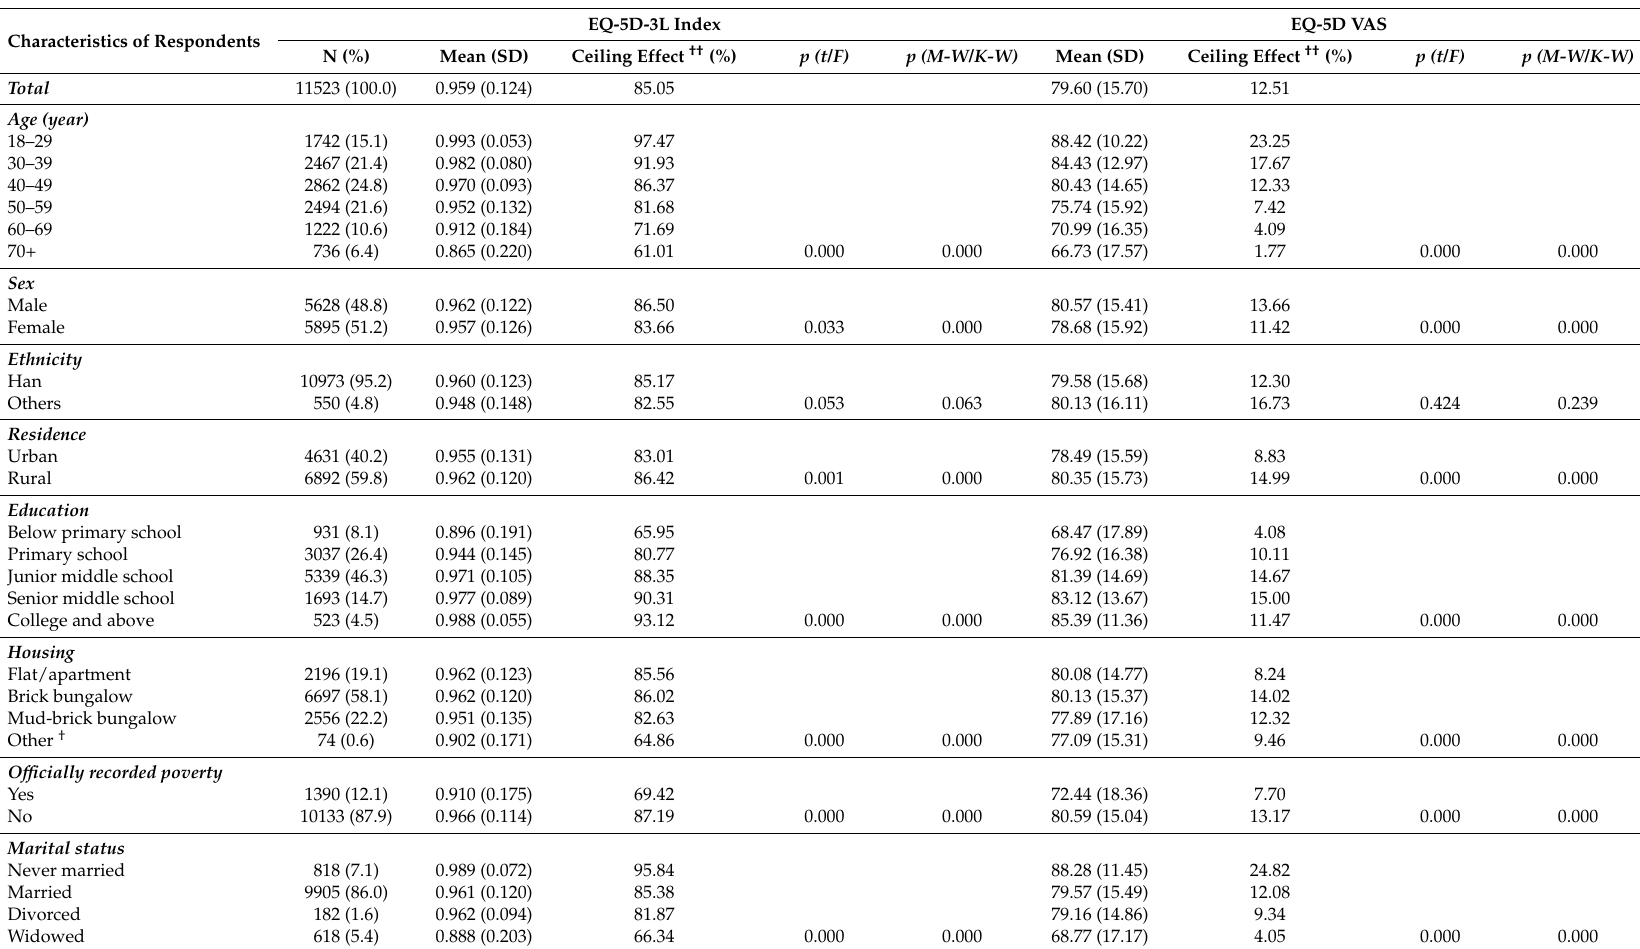
Table 1. Characteristics of respondents and EuroQol five-dimension three-level (EQ-5D-3L) index and visual analogue scale (VAS) scores. Characteristics of